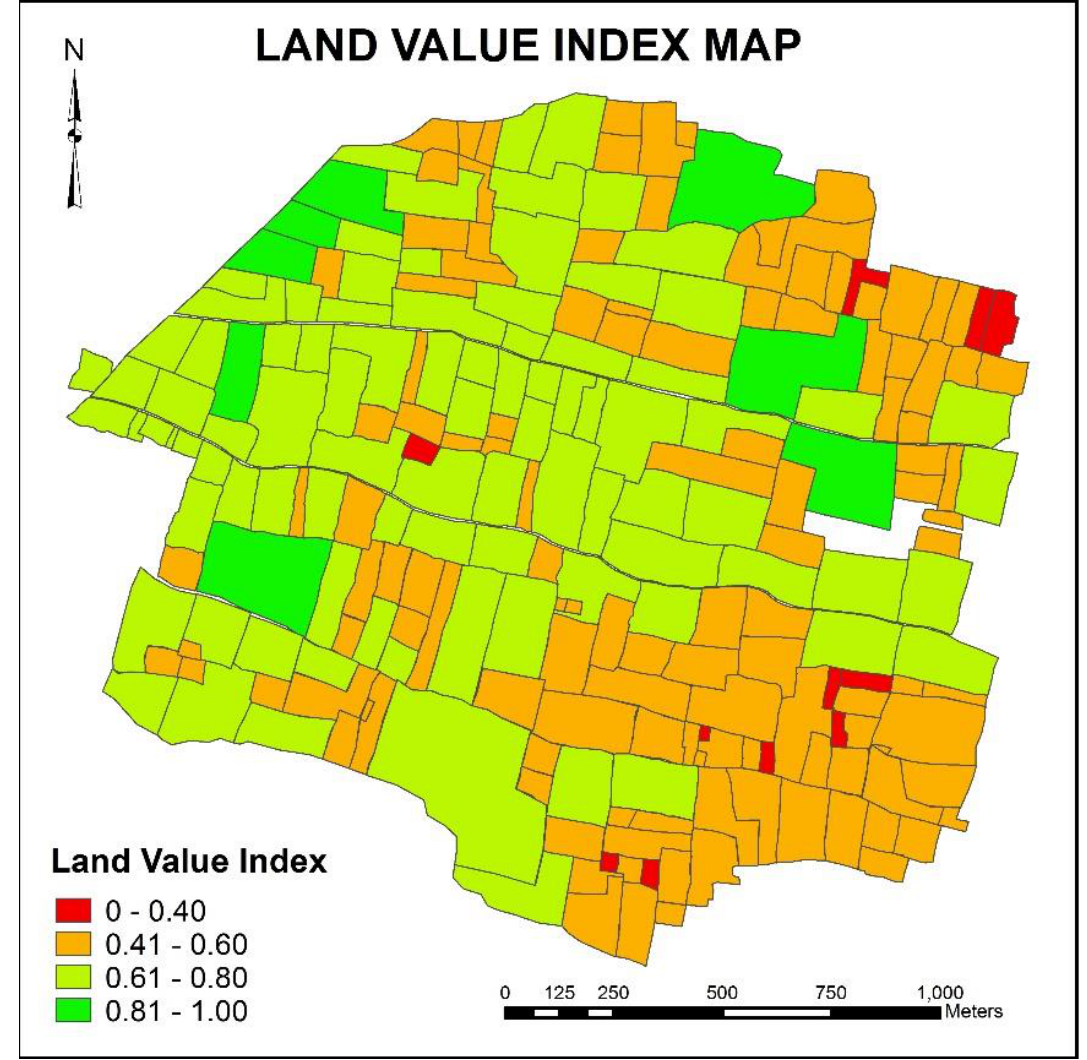
Figure 7. Land value index map of the area of interest.